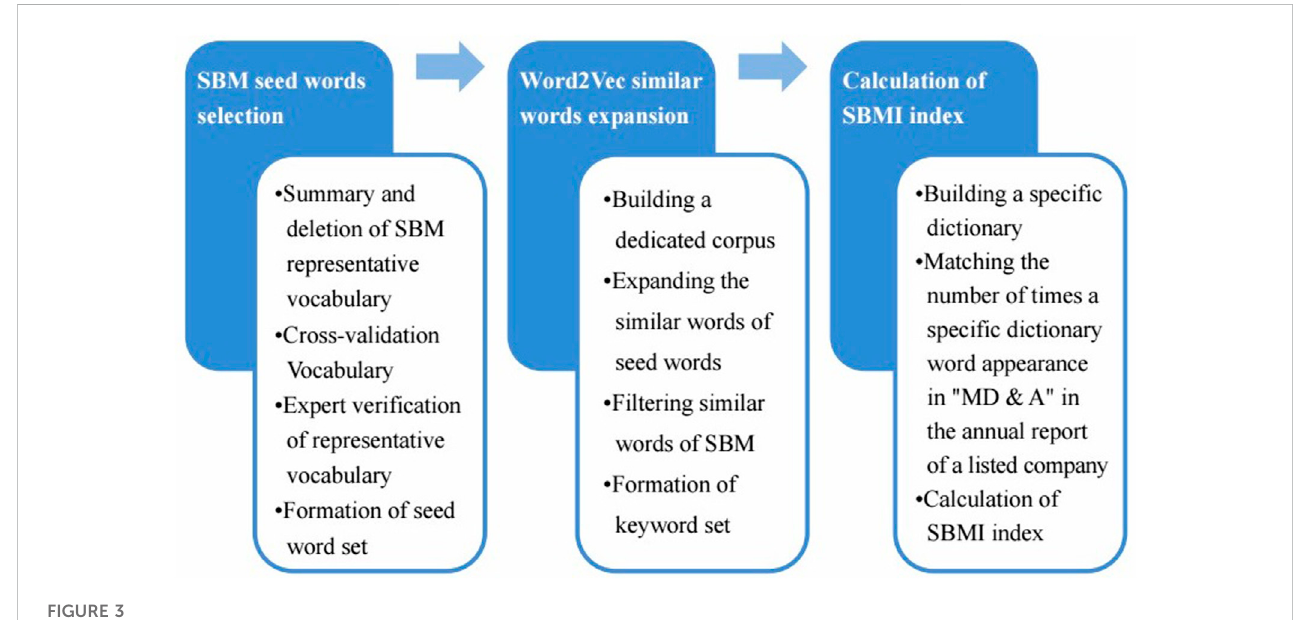
FIGURE 3 Diagram of proxy variable construction for